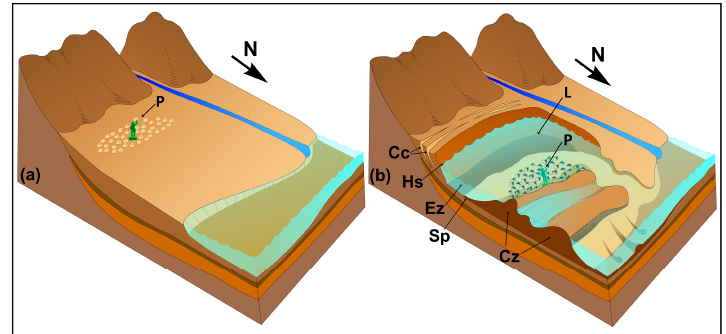
Figure 9. Three-dimensional sketch map, not in scale, of the landscape reconstruction of the delta plain where Helike was built before ( a ) and after ( b ) the translational slide, which affected the surficial sediments and caused the destruction and submergence of Helike. The translational slide in (b) has been enlarged more than that of the delta plain so that its geomorphological features are highlighted. (Cc): Crown cracks, (Hs): head of the slide, (Ez): evacuation zone, (Cz): compressional zone, (Sp): Slip plane and liquefaction horizon, (P): statue of Poseidon in upright position and (L):